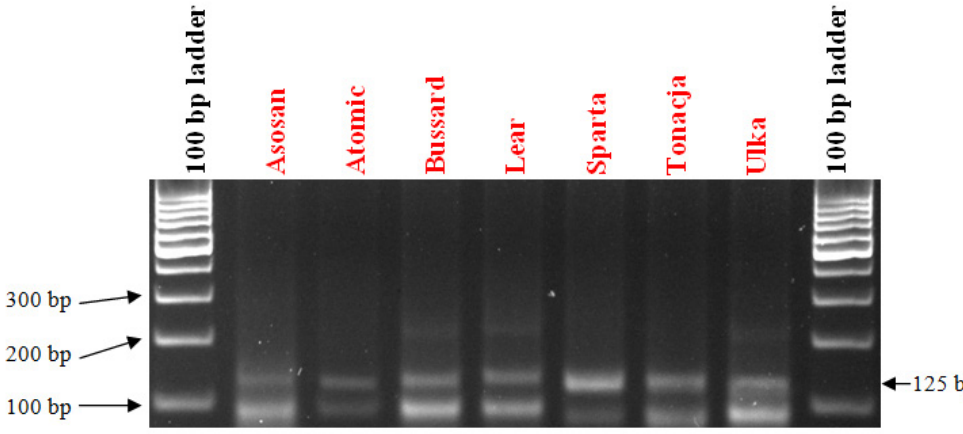
Figure 3: Electrophorogram showing the presence of the Xgwm382 marker of the Pm4b gene in wheat